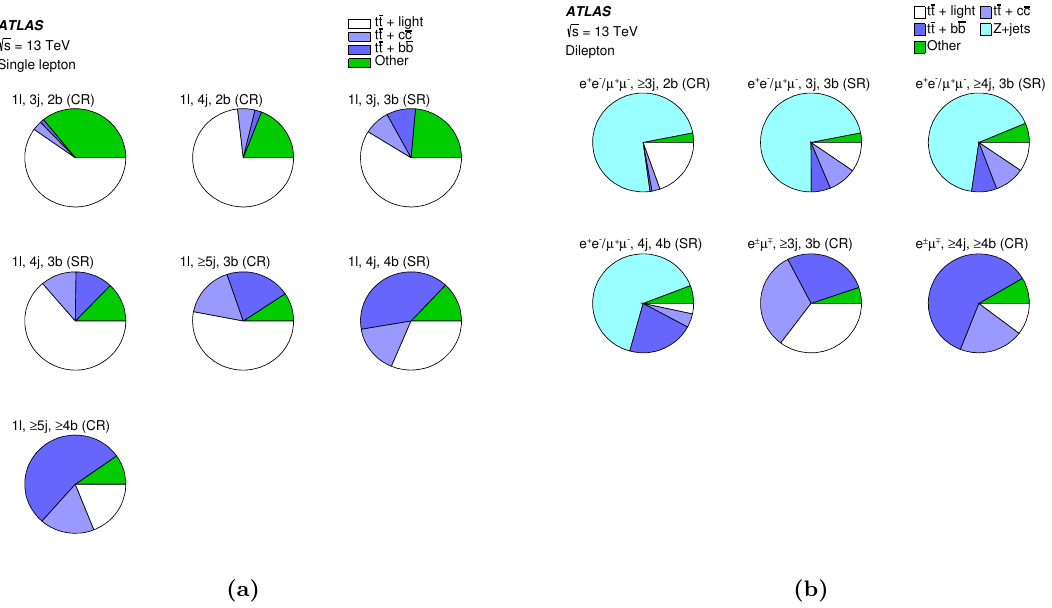
Figure 3. Fractional contributions of the various backgrounds to the total background prediction in the (a) single-lepton and (b) dilepton signal and control regions. The predictions for the vari- ous background contributions are obtained through the simulation and the data-driven estimates described in section 4. The t (cid:22) t background categories are also de(cid:12)ned in section